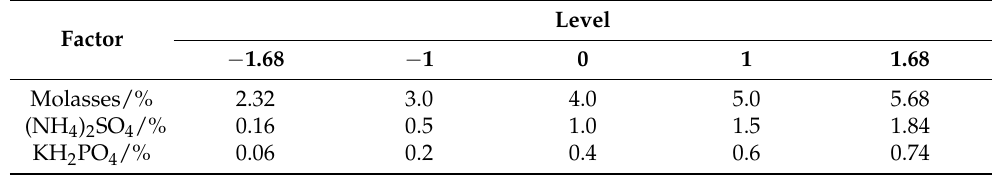
Table 2. Levels of the factors tested in the PB